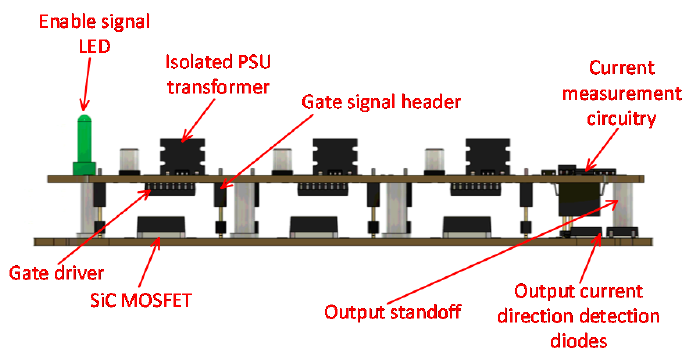
The power and driver board are stackable with one another. The signal connections are made through pin headers. The connection of power high-voltage lines is made through steel-tinned standoffs. On the power board, the standoffs are soldered directly to the board, and in the driver board, the mounting screw is used. The assembled 3D model of the power and driver board is shown in Figure 8.